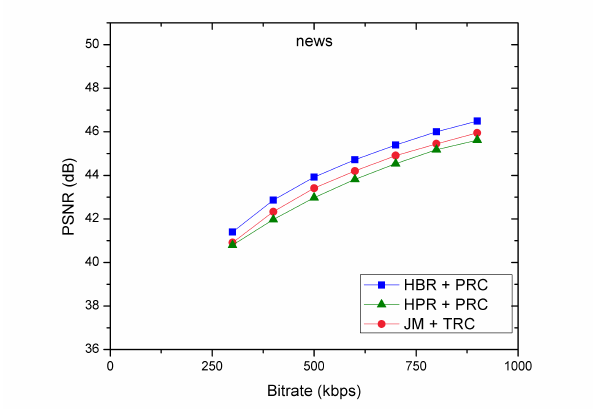
Fig. 3: RD performance for the rate control schemes